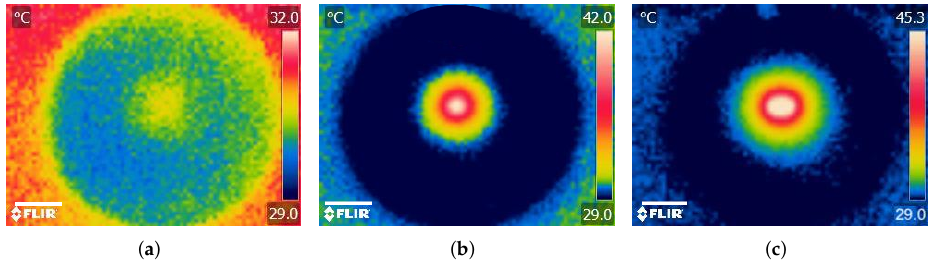
Figure 8. Photothermal heating generation in agarose gel results. Infrared thermographic images after NIR irradiation ( P 0 = 1.0 W, λ = 810 nm) of ( a ) agarose gel only (control) and agarose gel containing ( b ) a single and ( c ) double MNP-10 implants. Scale bar: 1.5